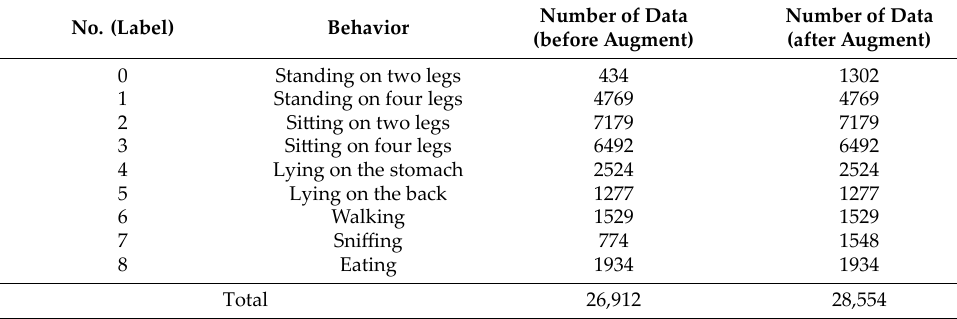
Table 5. Configuration before and after experimental dataset augmentation.